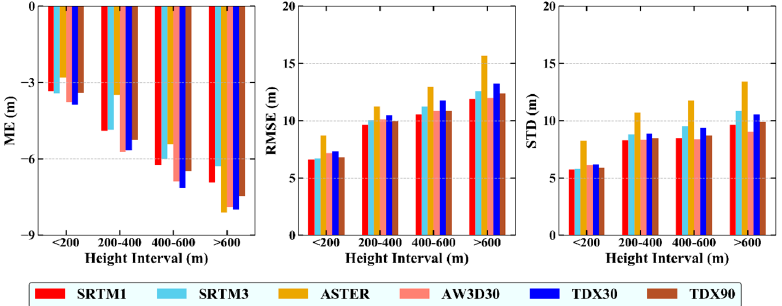
Figure 3. Mean Error (ME), Root Mean Square Error (RMSE) and Standard Deviation (STD) of the DEM errors.